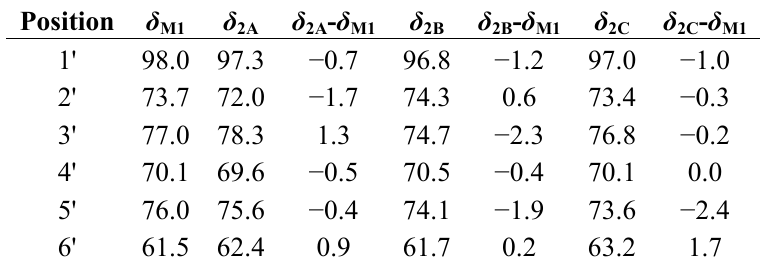
Table 4. 13 C-NMR data of the glycosyls in M1, 2A , 2B and 2C in CDCl J in Hz, recorded at 125 MHz).